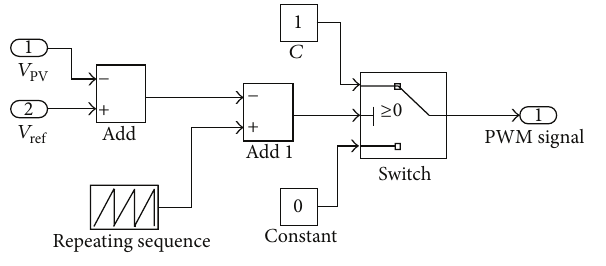
Figure 12: PWM intersect in SIMULINK.